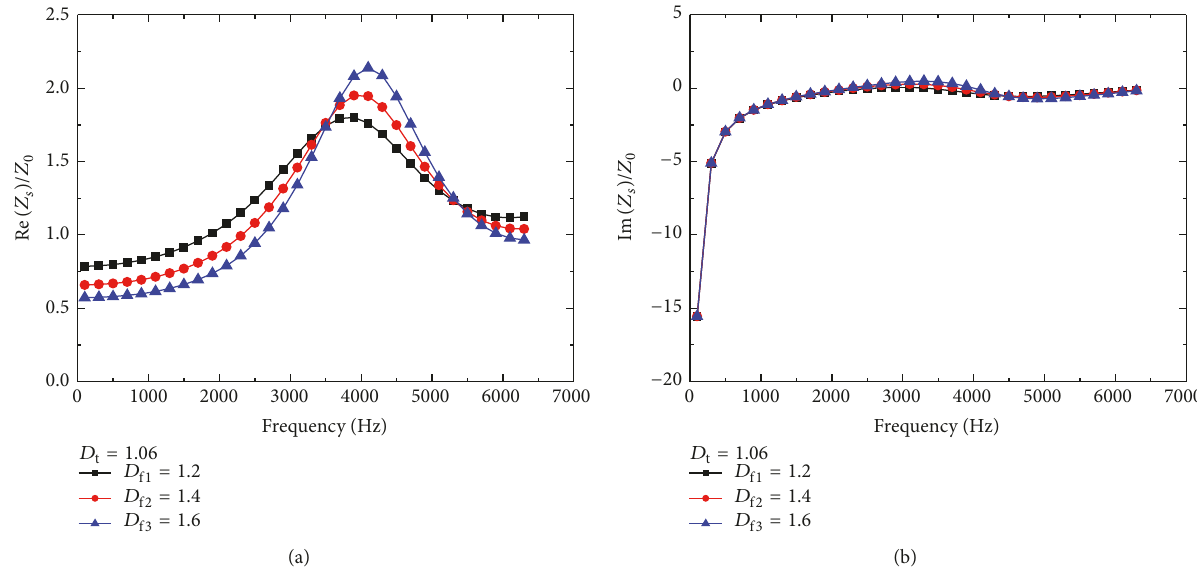
Figure 16: Predictions of specific surface acoustic impedance 𝑍 s / 𝑍 0 with different pore area fractal dimensions. (a) The real part of 𝑍 s / 𝑍 0 . (b) The imaginary part of 𝑍 s / 𝑍 0